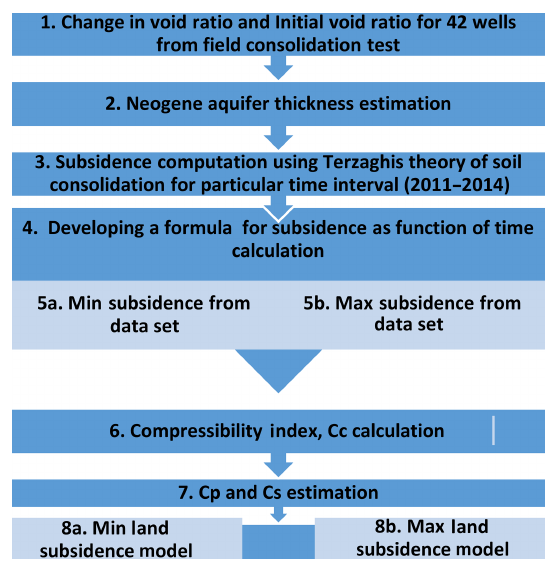
Figure 2. Flow chart of the research